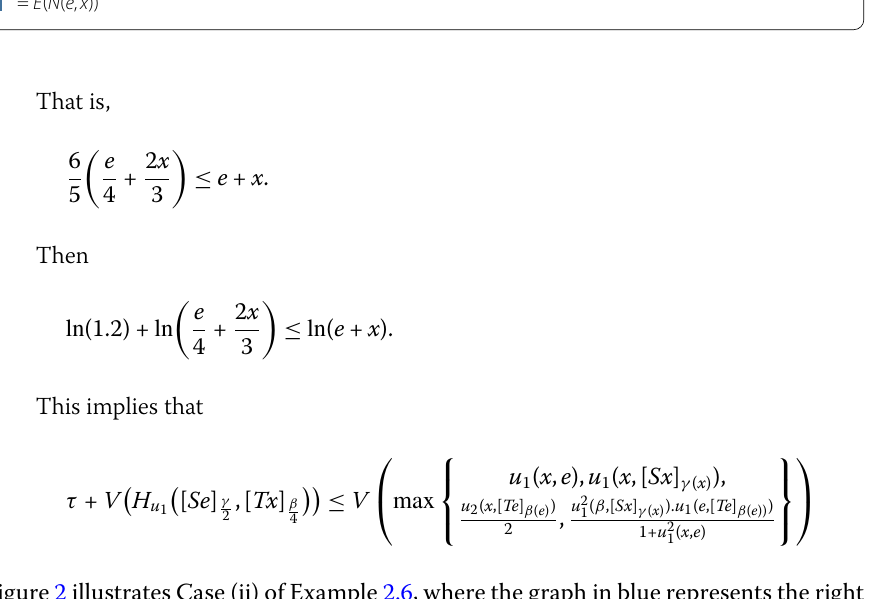
([ Se ] γ ,[ Tx ] β )) and E ( N ( e , x )). = V ( H u 1 2 4